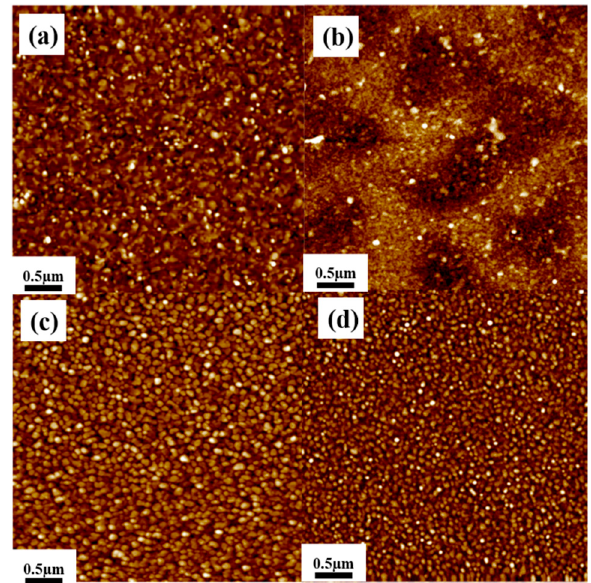
Figure 6. The surface roughness of the FePt(BN, Ag, C)( x vol.%)/MoC( y nm)/MgTiON/CrRu/glass films, ( x , y )= ( a ) (0, 0), ( b ) (10, 0), ( c ) (0, 3), ( d ) (10, 3).